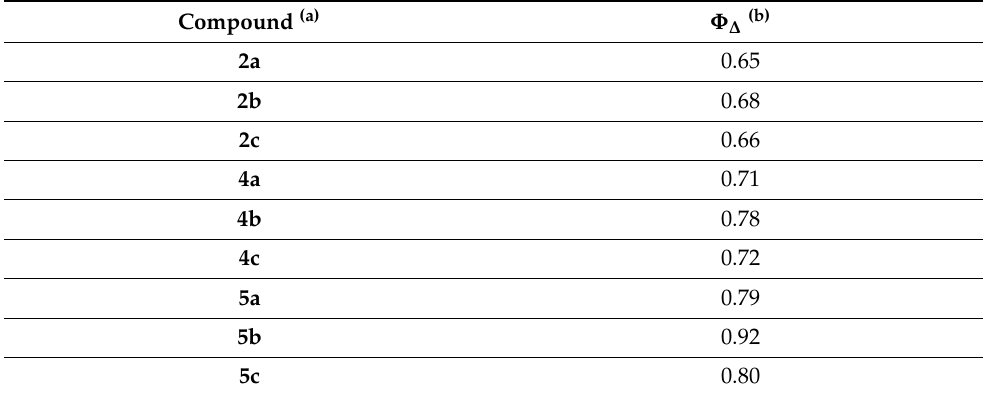
Figure 3. ( A ) Spectrally resolved direct detection of 1 O 2 generated by TPP and 4b and ( B ) time- resolved direct detection of 1 O 2 generated by TPP and 4b , λ exc = 420 nm. resolved direct detection of 1 O λ exc = 420 nm. 2 generated by TPP and 4b , Table 4. Singlet oxygen quantum yield ( Φ ∆ ) of porphyrins in DMF. Compound